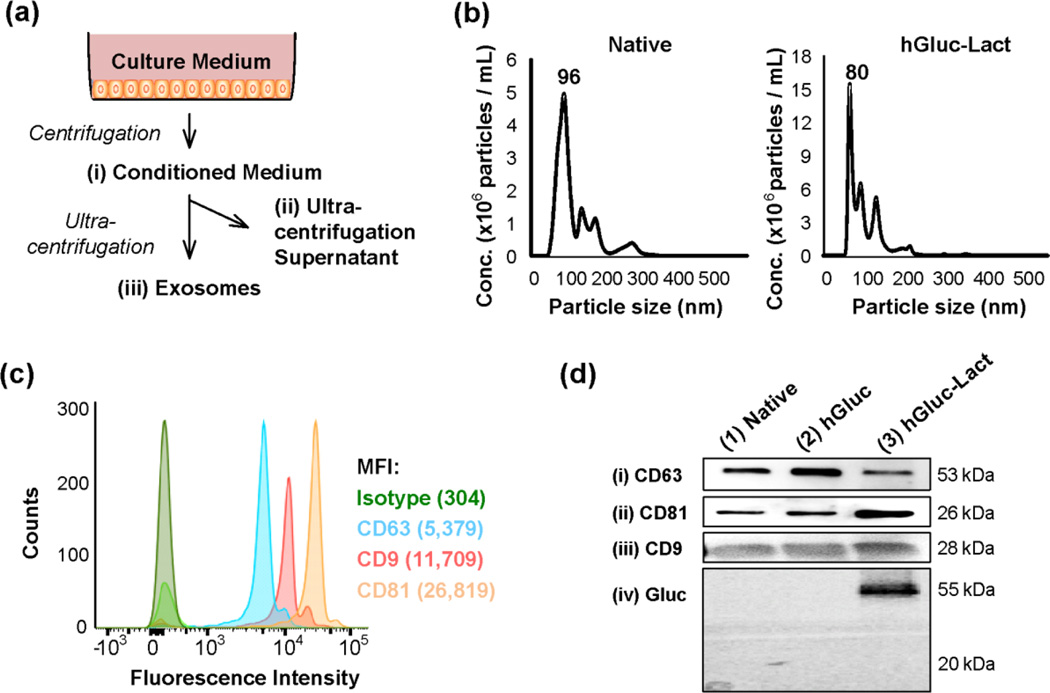
Exosome engineering and characterization(a) Schematic depiction of the isolation protocol for exosomes. (b) Size distribution of native and hGluc-Lact exosomes measured by nanoparticle tracking analysis (NTA). (c) Flow cytometry detection of exosome characterization. Exosomes were incubated with anti-CD63 Dynabeads and immunostained with exosomal surface markers (CD9, CD63, and CD81). Green histogram is the isotype control. Data were quantified and expressed as MFI (mean fluorescence intensity). (d) Western blot analysis of the marker proteins (i) CD63, (ii) CD81, and (iii) CD9 and (iv) Gluc on exosomes, respectively. Exosomes were purified from conditioned medium and characterized using western blot for the presence of typical exosomal markers CD63, CD81, and CD9. Additionally, Gluc detection by immunoblot of purified exosomes showed that hGluc-Lact fusion protein bound to the exosomal membranes.